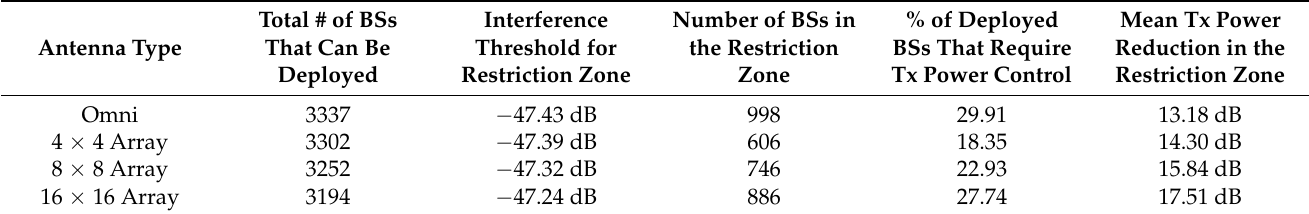
Table 4. Mean Tx power reduction in the restriction zone and the BS Tx power control in the RMa.